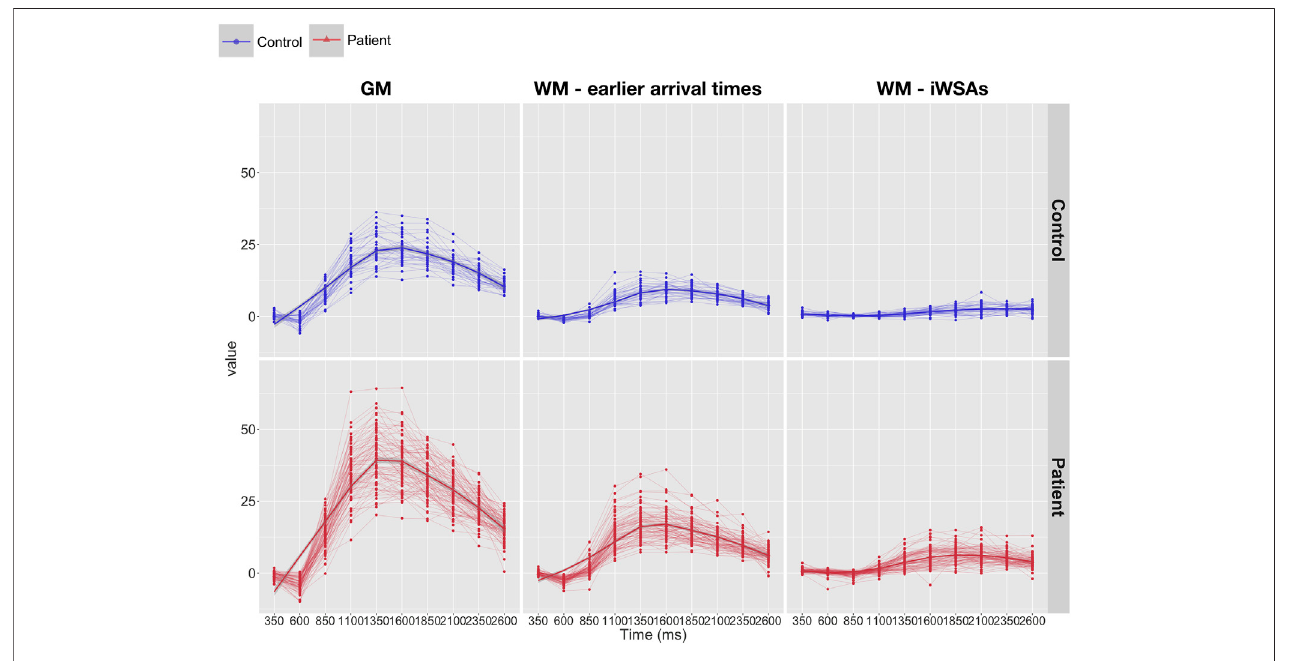
FIGURE 4 | Kinetic curves. Line-plots showing raw kinetic curves (i.e., difference signal at each timepoint) from the multi in fl ow time sequence across regions of interest in patients (bottom: shown in red) and controls (top: shown in blue). Abbreviations: GM, gray matter; WM, white matter; iWSAs, individual watershed areas.